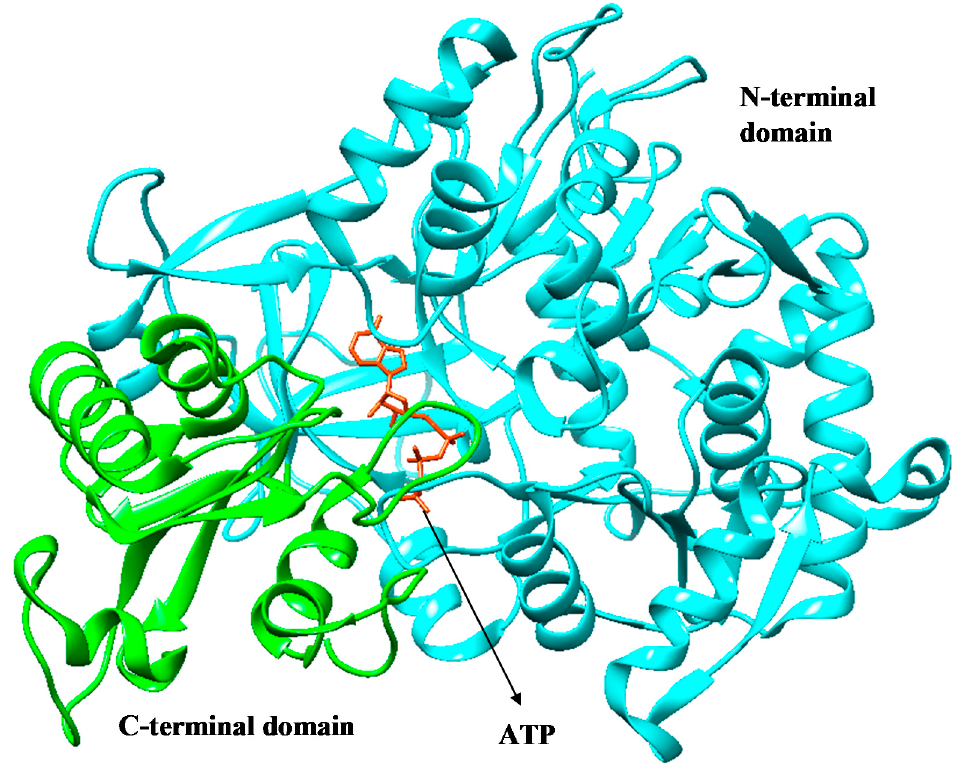
Figure 1. Three-dimensional (3D) structure of FadD32, showing the C-terminal domain (green) and the N-terminal domain (cyan), with the natural substrate, ATP (orange) [10].